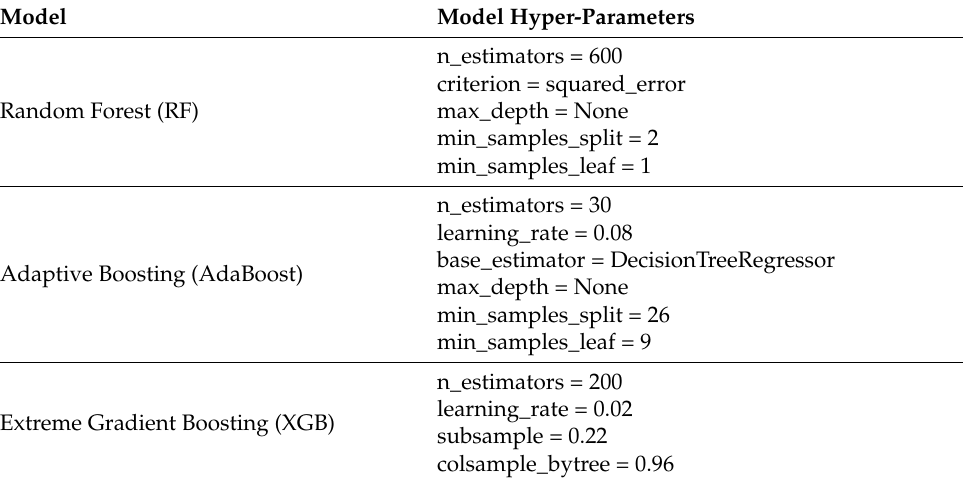
Table 1. Summary of the hyper-parameters for the three machine learning models. Model Model